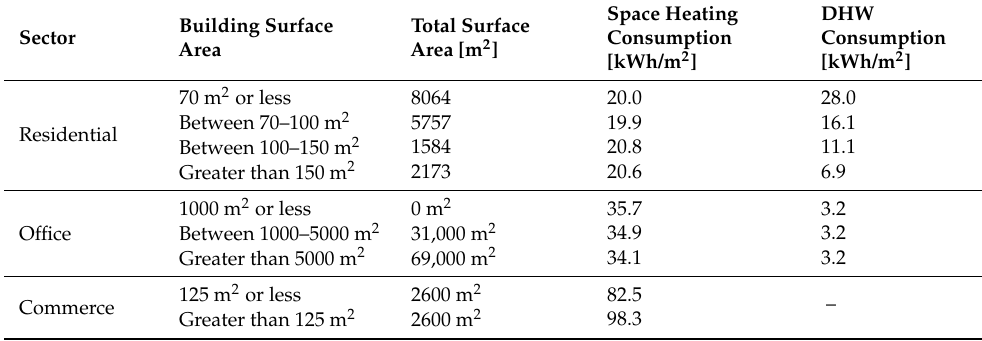
Table A1. Annual consumption of buildings constructed after 2012 in H1 zone (Chamb é ry, France).